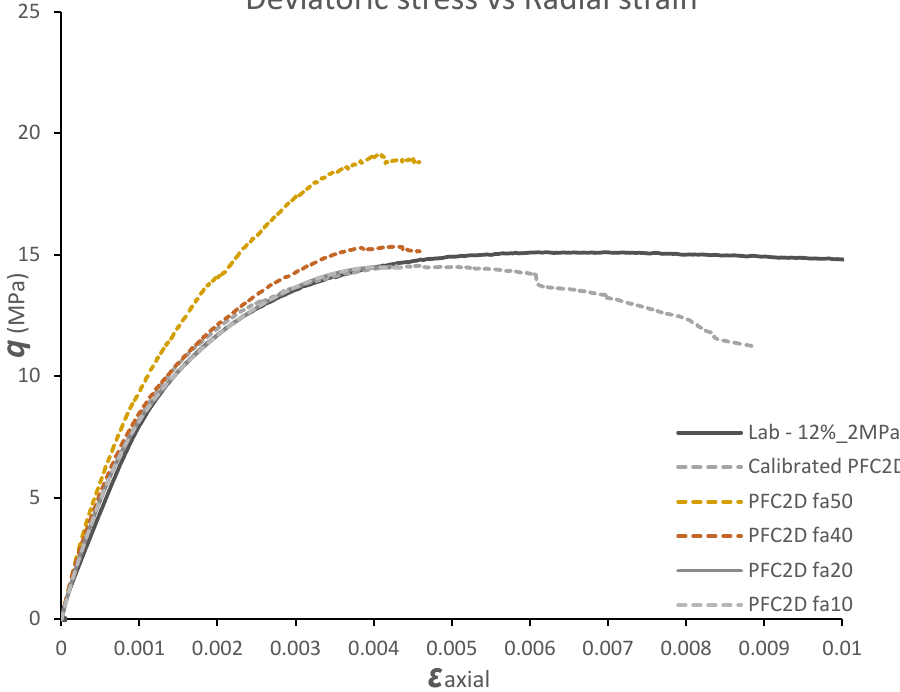
Figure 9. The effect of friction angle on deviatoric stress q.